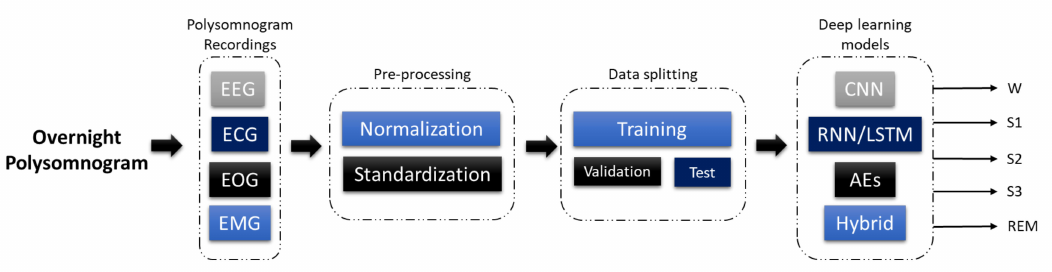
Figure 6. Programmed diagnostic tool (PDT) block diagram with DL for automated sleep stage